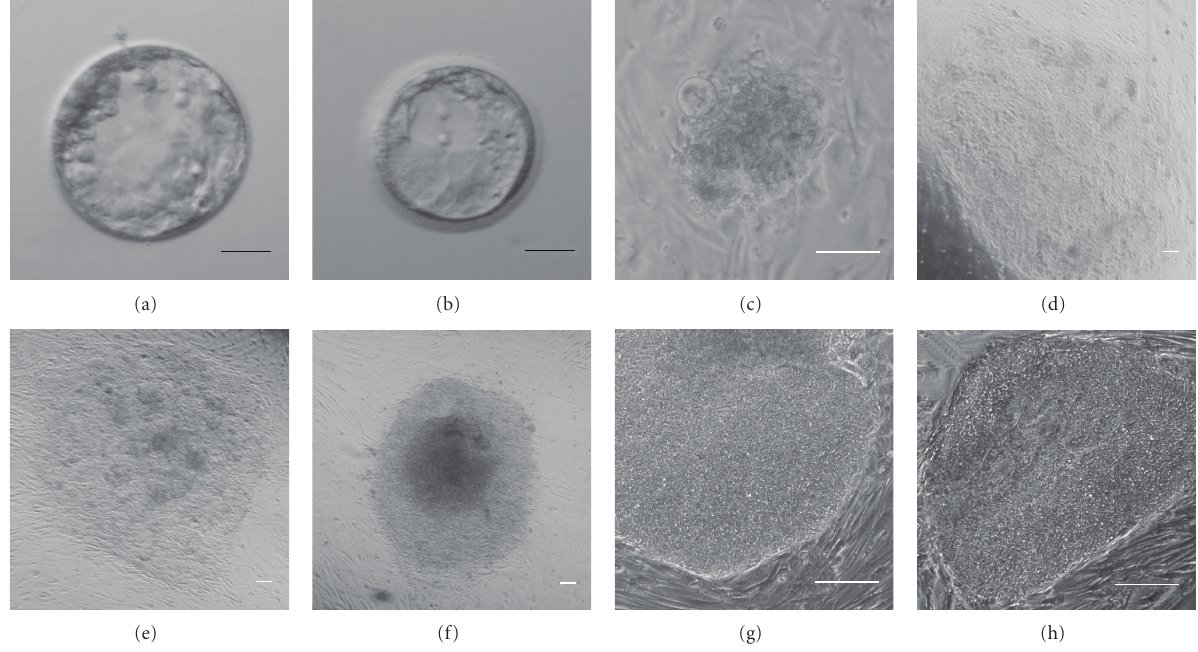
Figure 1: Nonviable ED6 embryos, showing cavitation but either no or highly abnormal ICMs, initial outgrowths, and typical colony appearance. Brightfield images of embryos used for CU1 (a) and CU2 (b) hESC derivation. Phase contrast images of representative initial outgrowths two (c), five (d), or 14 days (e) postplating and typical established hESC colonies (f, g, h). Scale bar = 20 µ m (a, b); 100 µ m